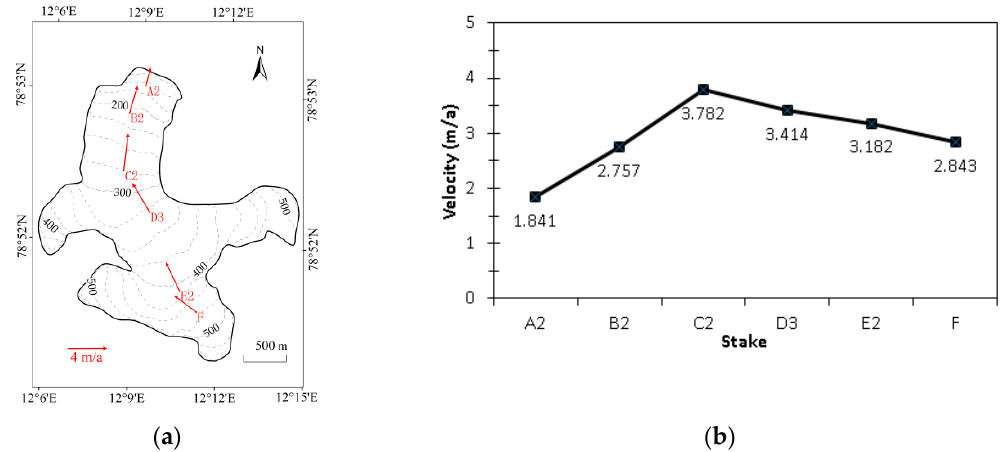
Figure 4. The mean velocities (m/a) over 2005-2016 of stakes along the central flow line. ( a ) The ice flow velocity field along the central flow line. ( b ) The velocity values at 6 stakes.